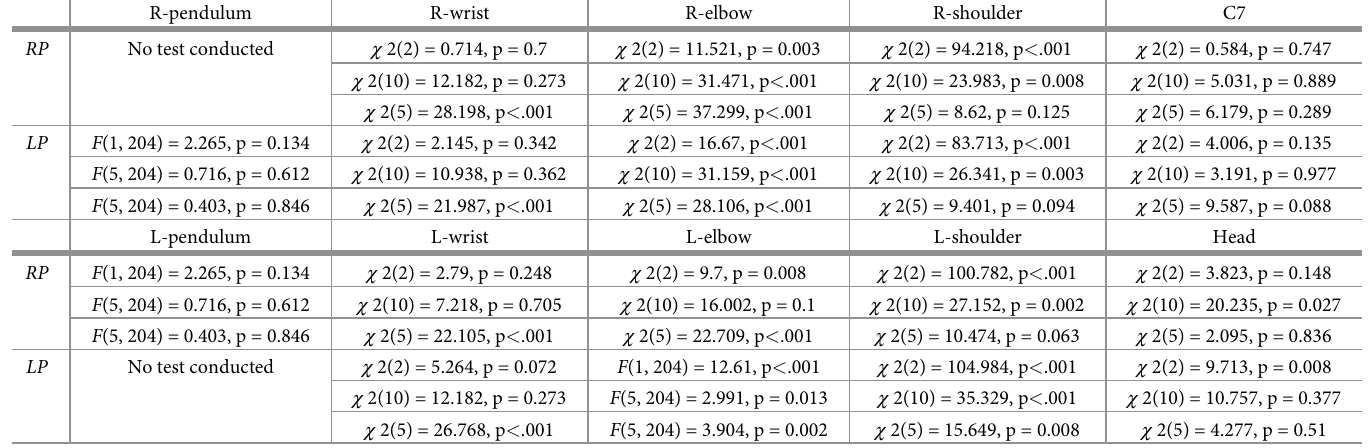
Table 4. Results of the two-way Harrison-Kanji test for phase differences (anti-phase condition). R-pendulum R-wrist R-elbow R-shoulder